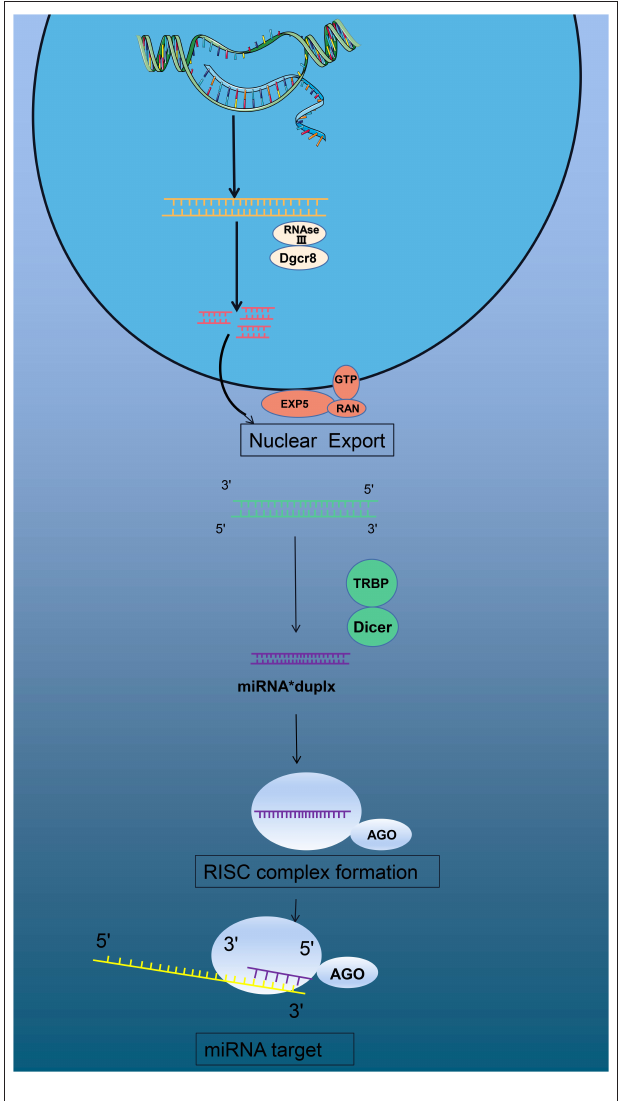
FIGURE 1 | miRNAs form and